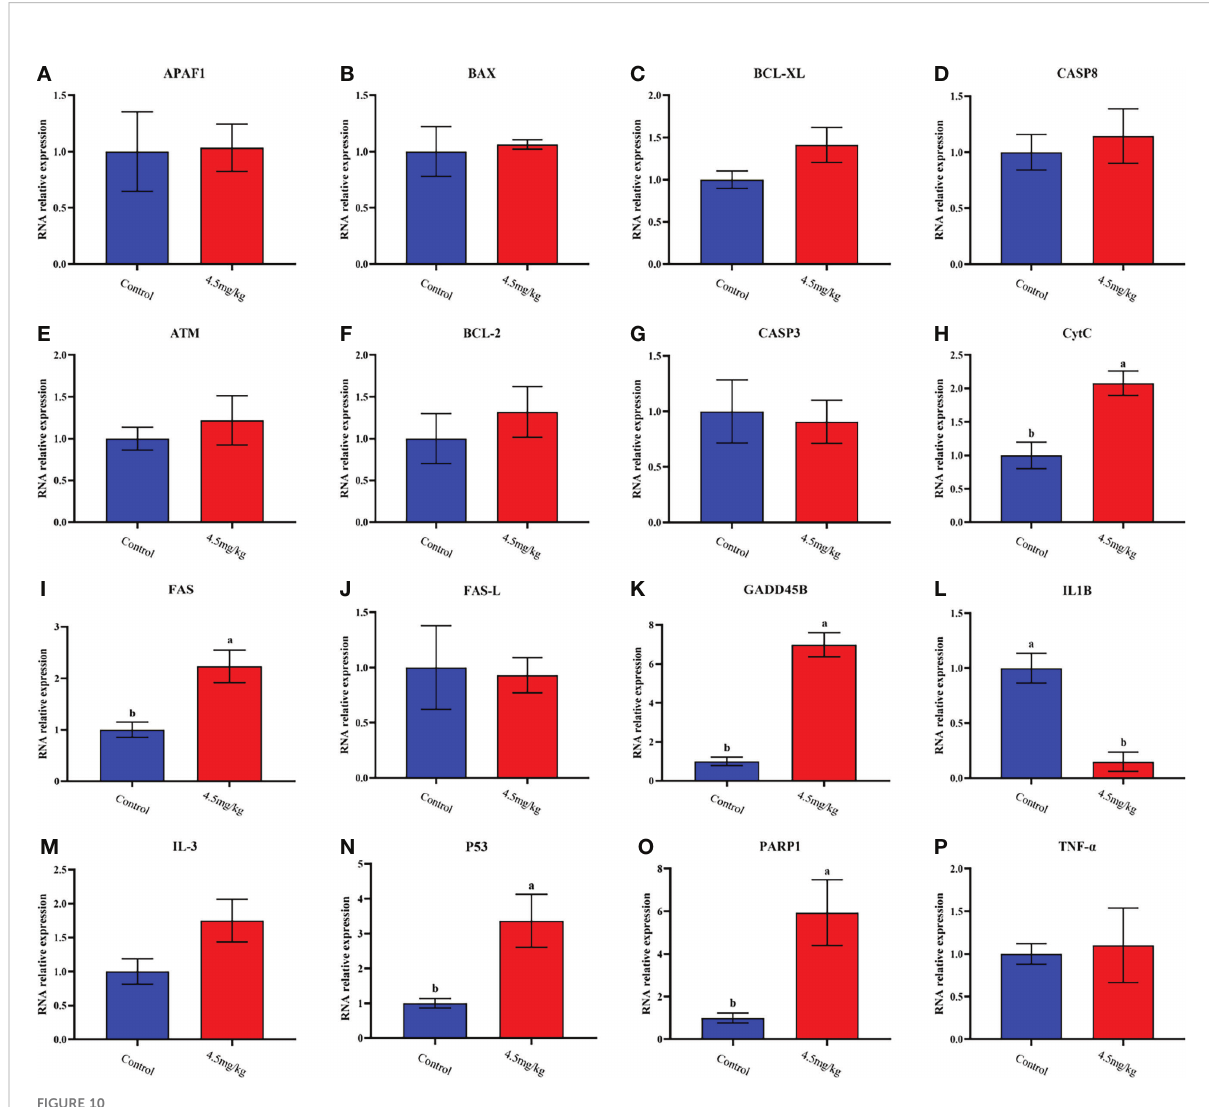
FIGURE 10 Quantitative analysis of apoptosis dredging genes in dorsal adipose tissue. (A) APAF1; (B) BAX; (C) BCL-XL; (D) CASP8; (E) ATM; (F) BCL-2; (G) CASP3; (H) CytC; (I) FAS; (J) FAS-L; (K) GADD45B; (L) IL-1 b ; (M) IL-3; (N) P53; (O) PARP1; (P) TNF- ɑ ; Different lowercase letters indicate P <0.05 vs